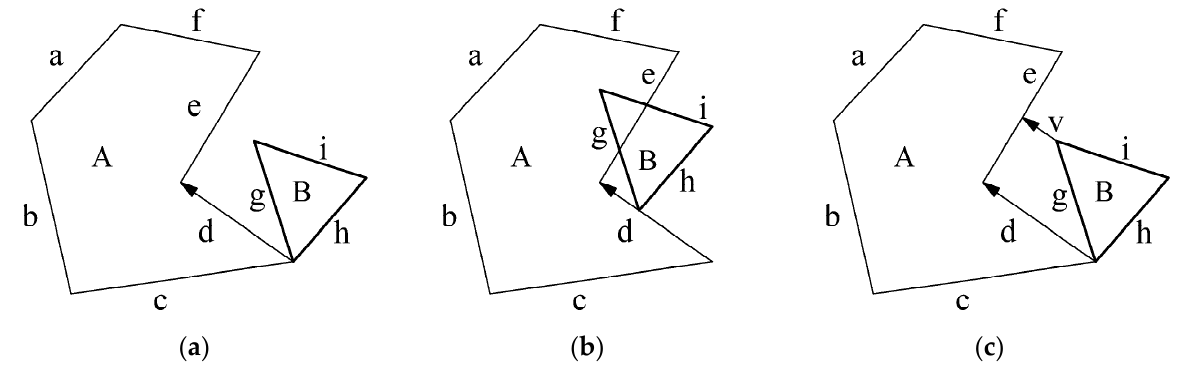
Figure 9. Illustration of shortening a translation vector to avoid overlap. ( a ) The translation vector is edge d ; ( b ) Overlap between A and B ; ( c ) The translation distance is the length of vector v .